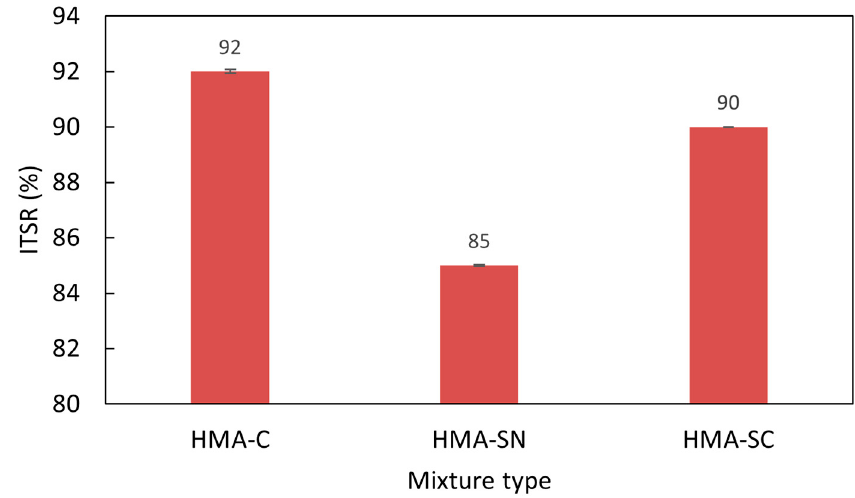
Figure 6. Indirect tensile strength ratio for HMA mixtures.